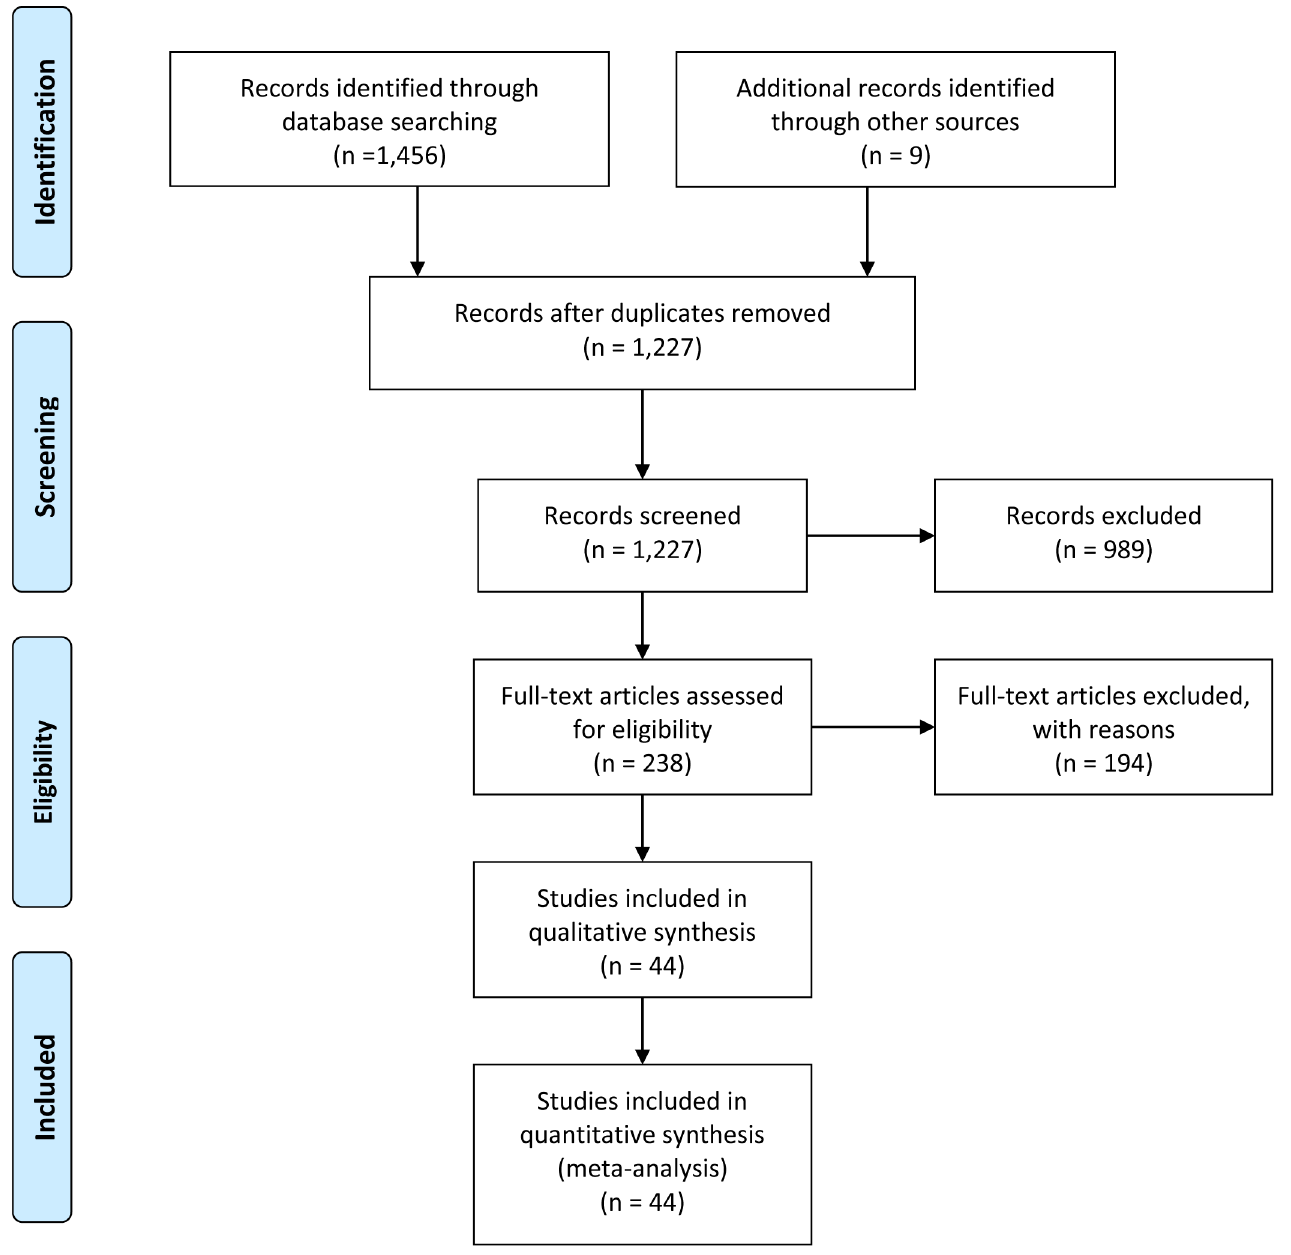
Fig 1. A Flow Diagram showing the RCTs